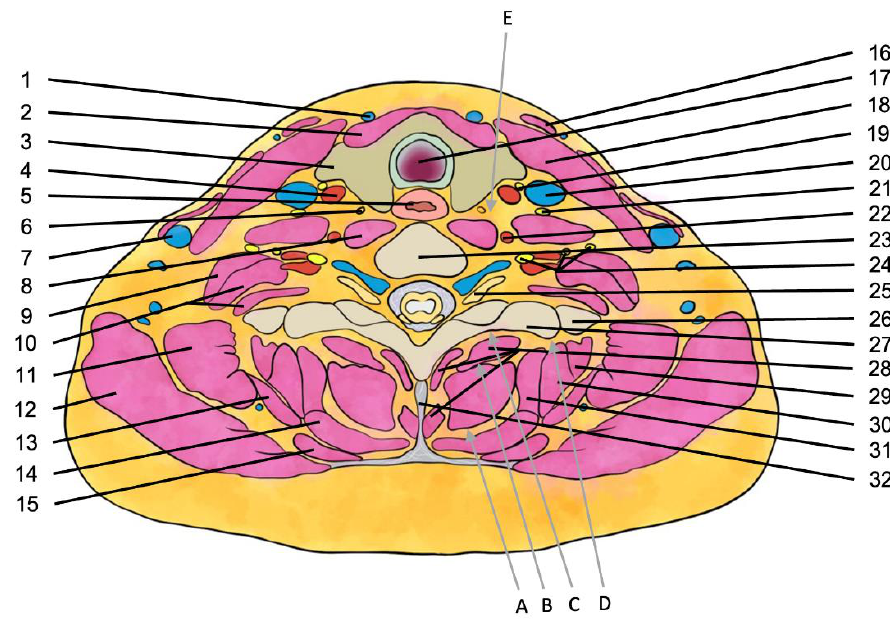
Figure 3. Cross-section of the neck at the level of C7/C8. The arrows indicate the needle trajectories for: A — inter-semispinal plane block; B — multifidus cervicis plane block; C — retrolaminar cervical block; D — cervical erector spinae plane block; E — medial transthyroid stellate ganglion block. 1 — anterior jugular vein; 2 — sternothyoid muscle; 3 — thyroid gland; 4 — common carotid artery; 5 — sympathetic trunk; 6 — sympathetic trunk; 7 — external jugular vein; 8 — longus colli muscle; 9 — mid- dle scalene muscle; 10 — posterior scalene muscle; 11 — levator scapulae muscle; 12 — trapezius mus- cle; 13 — serratus posterior superior muscle; 14 — splenius capitis muscle; 15 — rhomboid minor mus- cle; 16 — platysma; 17 — sternocleidomastoid muscle; 18 — trachea; 19 — vagus nerve; 20 — internal jugular vein; 21 — phrenic nerve; 22 — vertebral artery; 23 — cervical vertebra (C7); 24 — Spinal nerves (C5, C6, and C7); 25 — Spinal nerve root (C8); 26 — First rib; 27 — transverse process of vertebra; 28 — multifidus muscle; 29 — iliocostalis cervicis muscle; 30 — longissimus cervicis muscle; 31 — splenius cervicis muscle; 32 — interspinous ligament. Scheme based on [67]. 7. Stellate Ganglion Block The stellate ganglion, located lateral to the trachea and esophagus, anterior to the longus colli muscle at C7, and posteromedial to the carotid sheath [68], is made up of the inferior cervical and first thoracic ganglia, and it provides sympathetic innervation to the upper extremities, head, neck, and heart. Angina pectoris, cardiac arrhythmias, bronchial asthma, primary hypertension, vascular headache, and chronic neuropathic pain may be diagnosed and treated with stellate ganglion block (SGB) [69 – 73]. SGB was first performed using a typical blind procedure [74,75] with injections of local anesthetic; however, this technique had a significant risk of adverse effects. SGB has been carried out using a variety of approaches, including anterior, lateral, and posterior, using several different techniques: fluoroscopy [76], CT [77,78] and recently ultrasounds [79 – 81]. Fluoroscopy became the standard of care for SGB; however, it has its own limita- tions, e.g., cannot see blood vessels near the stellate ganglion [82]. The block was more effective and safer with ultrasound guidance than with fluoroscopy guidance alone. Ul- trasound, as opposed to fluoroscopy-guided blocking, prevents intravascular injections and soft tissue injury [80] (Figure 4).